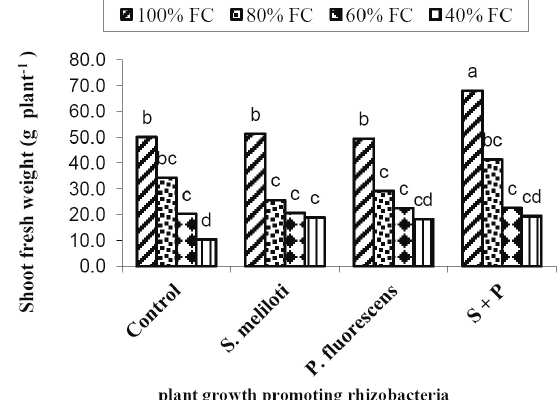
fig. 2 - Interaction of PGPR and soil water content on the shoot fresh weight fenugreek.